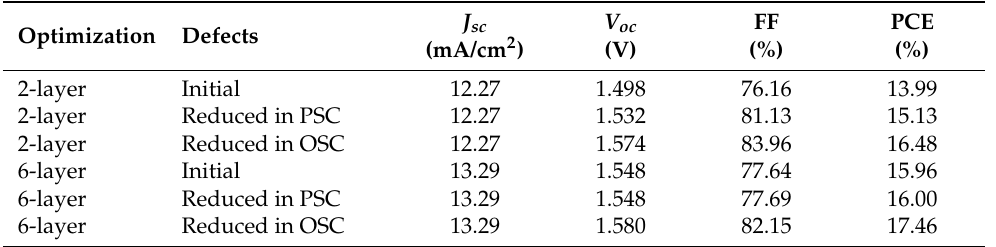
Figure 11. The illuminated J-V curves when modifying the defects in PSC and OSC for ( a ) 2-layer optimization and ( b ) 6-layer optimization. Table 3. Key tandem factors based on full optoelectronic optimization for 2-layer and 6-layer opti- mization under various situations of defects.